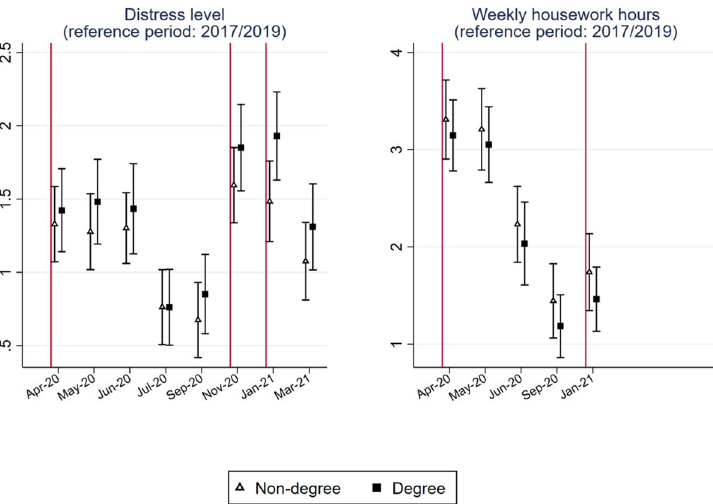
Fig 9. Point estimates and 95% confidence interval of the education-period interaction models to predict subjective wellbeing and housework time.